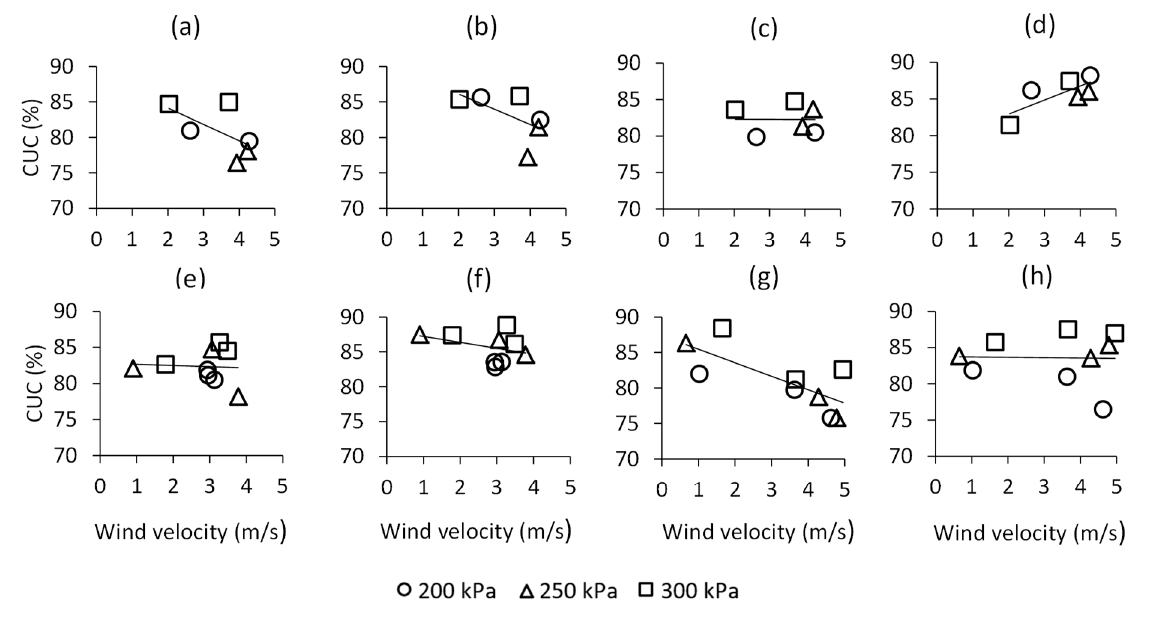
Figure 6. Christiansen uniformity coefficient for the impact sprinklers analyzed for all the experimental tests of wind velocity and operating pressure.